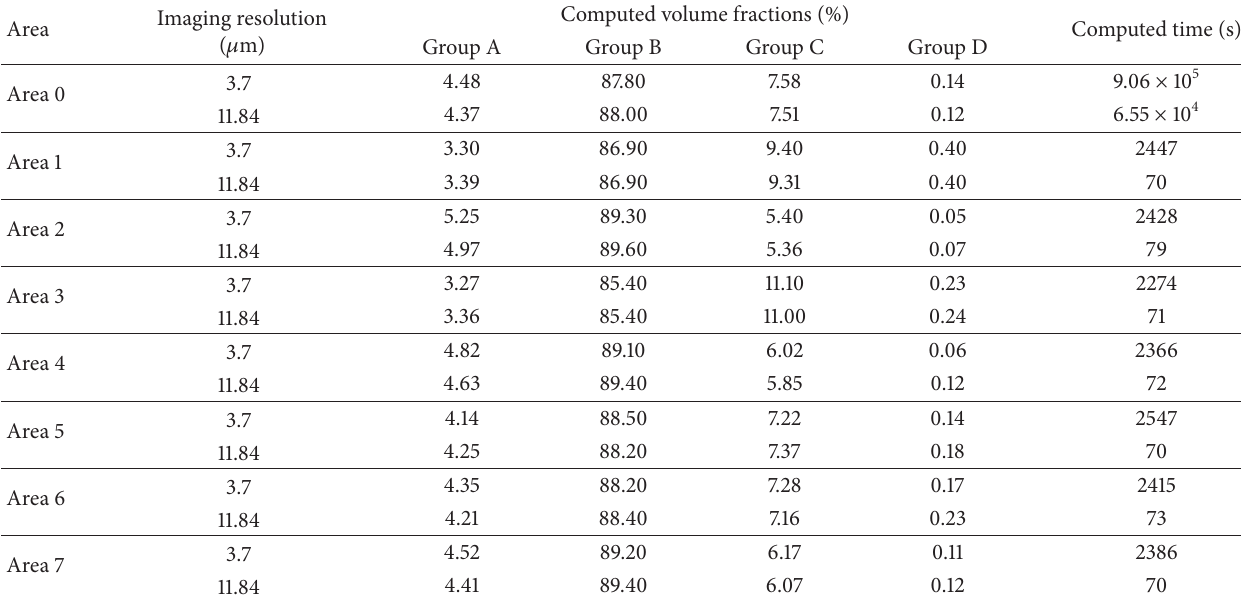
Table 2: DCM computed average composition group volume